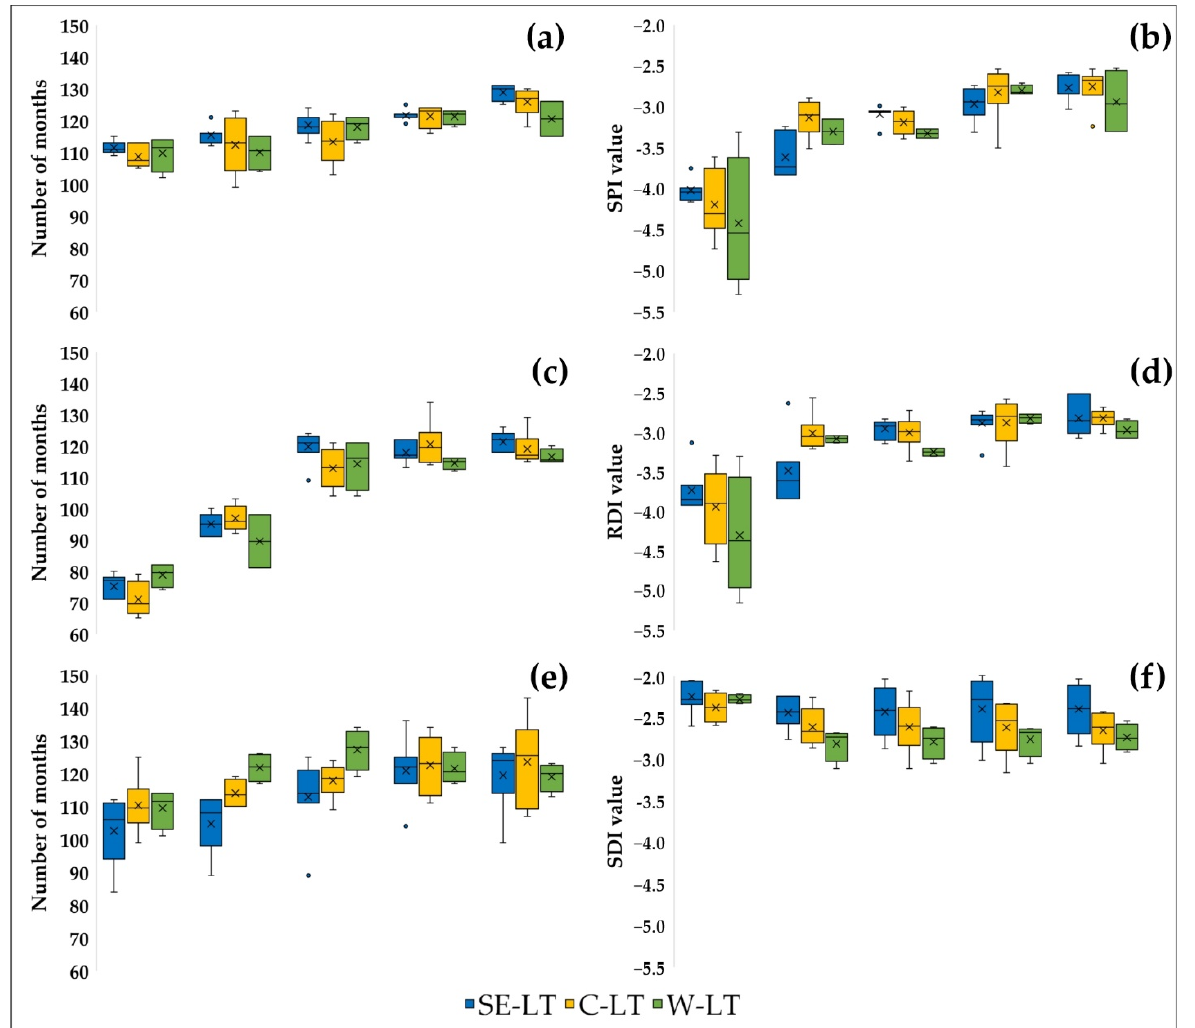
Figure 3. Distribution of drought values in the different hydrological regions (the accumulation period increases from left to right: 1, 3, 6, 9 and 12, respectively): ( a ) number of dry months for SPI-index; ( b ) distribution of minimum values by region for SPI-index; ( c ) number of dry months for RDI-index; ( d ) distribution of minimum values by region for RDI-index; ( e ) number of dry months for SDI-index; ( f ) distribution of minimum values by region for SDI-index.